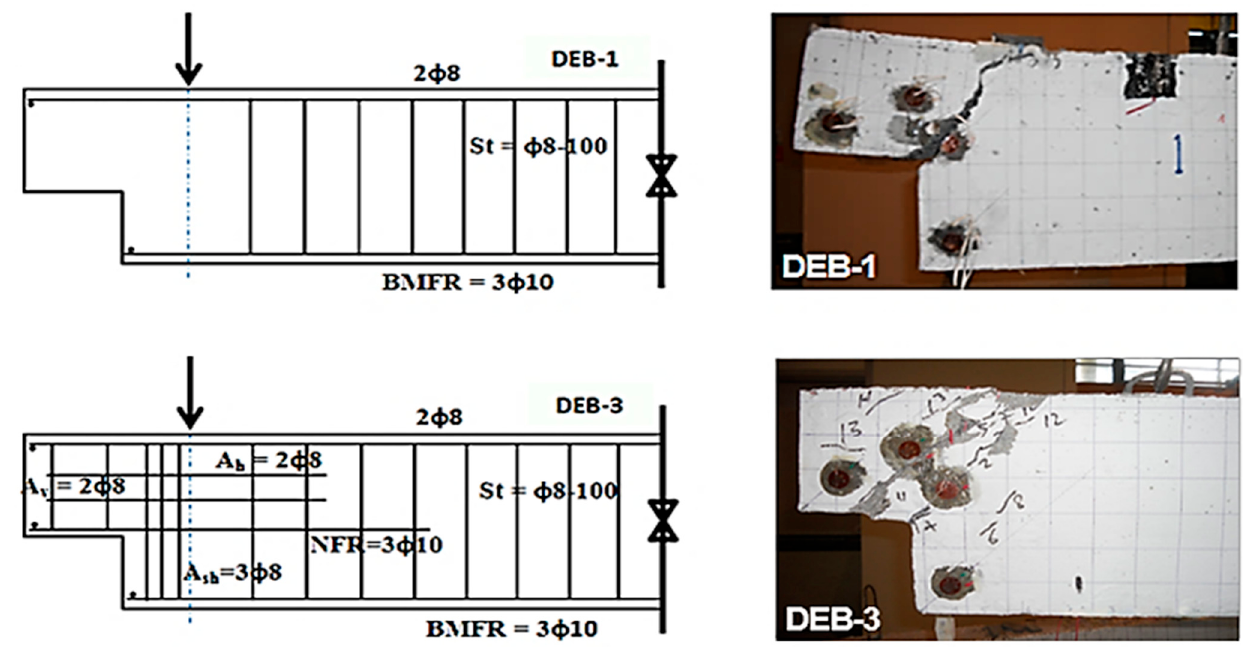
Figure 4. Reinforcement detail and modes of failure of DEB-1 and DEB-3.